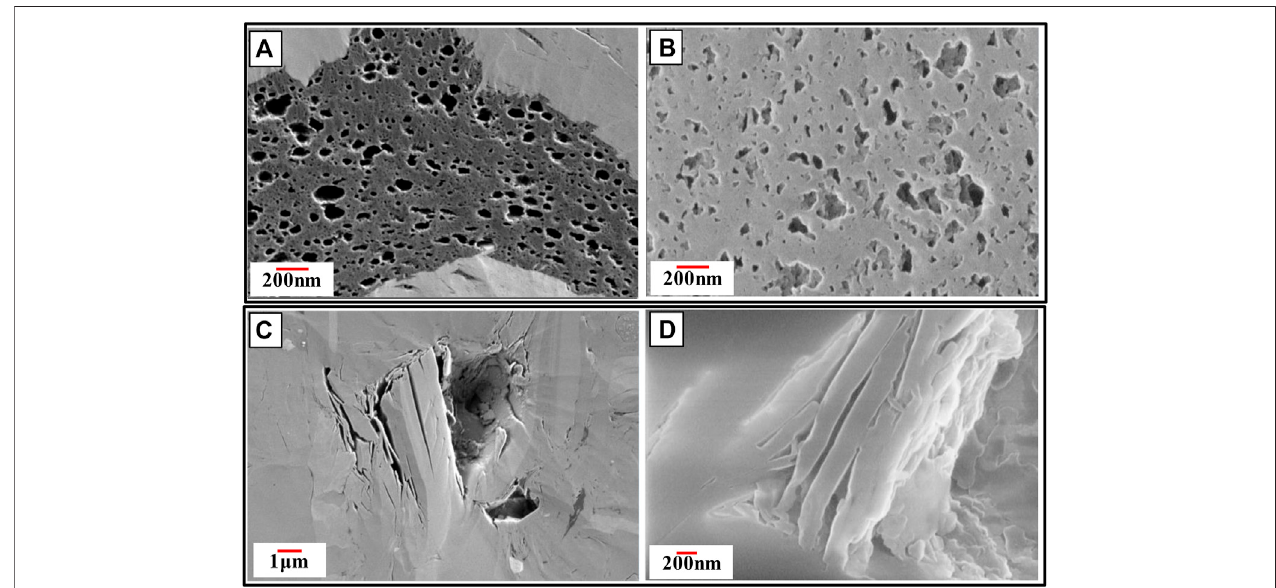
FIGURE 7 | In JiaoYe 1 Well in the Long 1 Fm.: FIB-SEM and FIB-HIM images of shales in the fi rst sum-member and third member. In JiaoYe 1 Well in the Long 1 Fm., 2402 m: Organic pores: (A) FIB-SEM image, (B) FIB-HIM image; In JiaoYe 1 Well in the third member of Longmaxi Formation, 2339 m: Clay Mineral Pores: (C) FIB-SEM Image, (D) FIB-HIM Image.